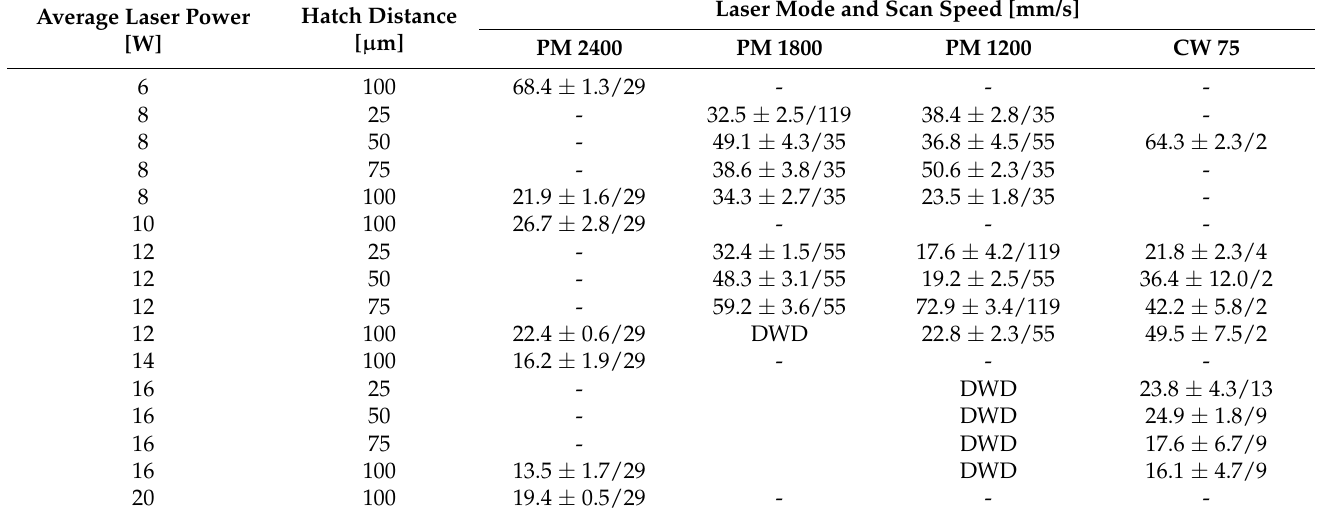
Table 2. The values of the contact angle [deg] measurements for water for selected parameters of Ti6Al4V functionalization. After a slash (/x), a day is given when the measurement of the contact angle was